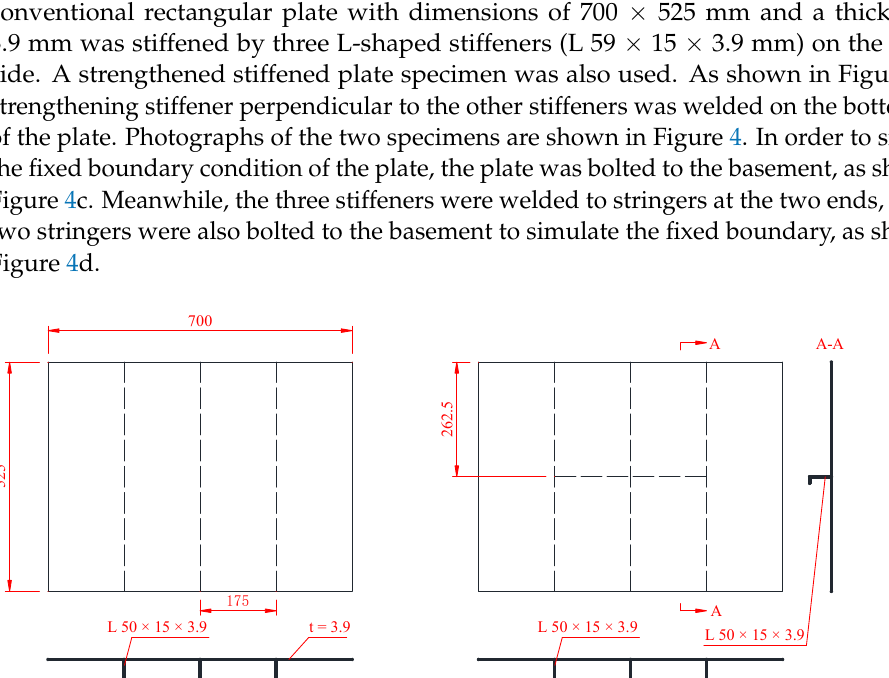
( d ) Figure 4. Photographs of the specimens: ( a ) conventional stiffened plate (unit: mm); ( b ) strength- ened stiffened plate; ( c ) bolt arrangement; ( d ) stringer and the bolt on the backside. 3.2. Mechanical Properties Both a quasistatic tensile test and a dynamic tensile test of the mild steel were carried out at room temperature. Under the guidance of the Chinese metallic materials tensile test standard GB/T 228.1 [27], dog-bone-shaped test specimens were cut from the mild steel plate by wire electrical discharge, as shown in Figure 5. The quasistatic test specimen and the dynamic test specimen have the same thickness of 3.9 mm, which is equal to the thick- ness of the panel of the rectangular dropping weight impact test specimens. For the